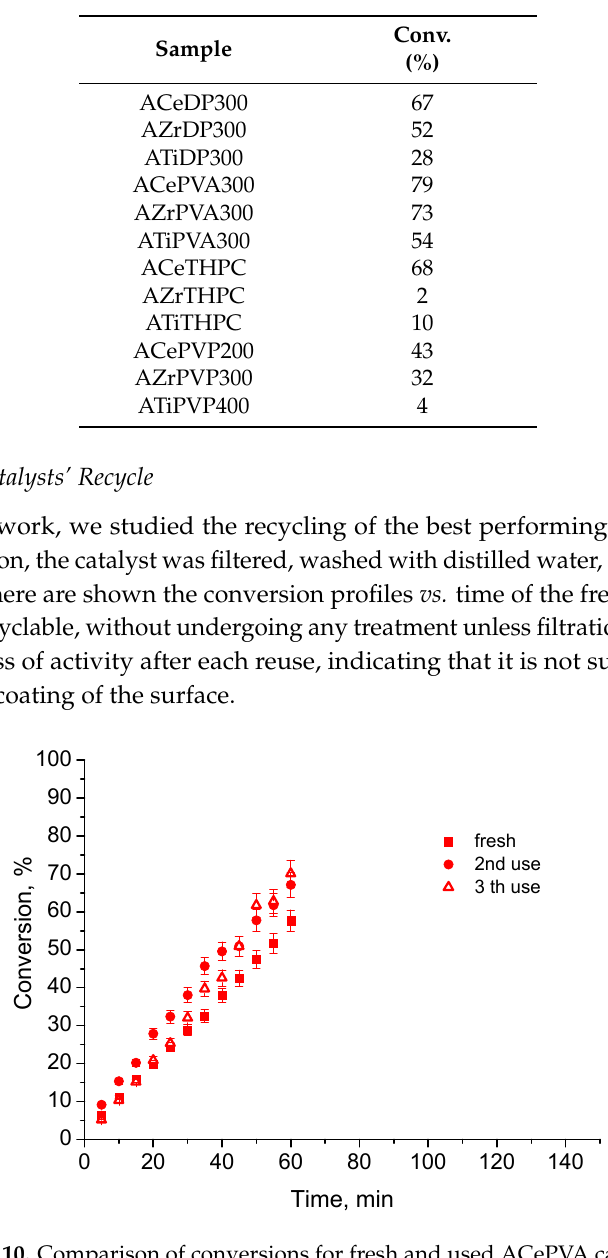
Figure 10. Comparison of conversions for fresh and used ACePVA catalysts.